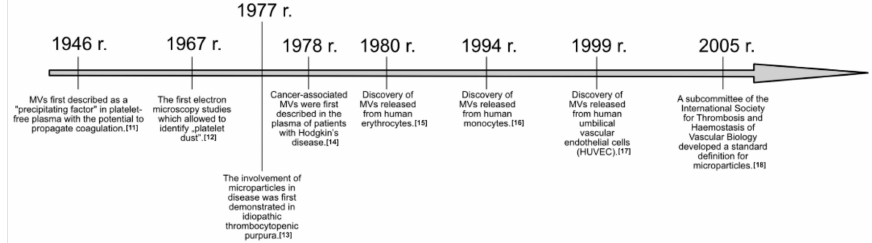
Figure 1. Timeline of the significant discoveries in extracellular vesicles research